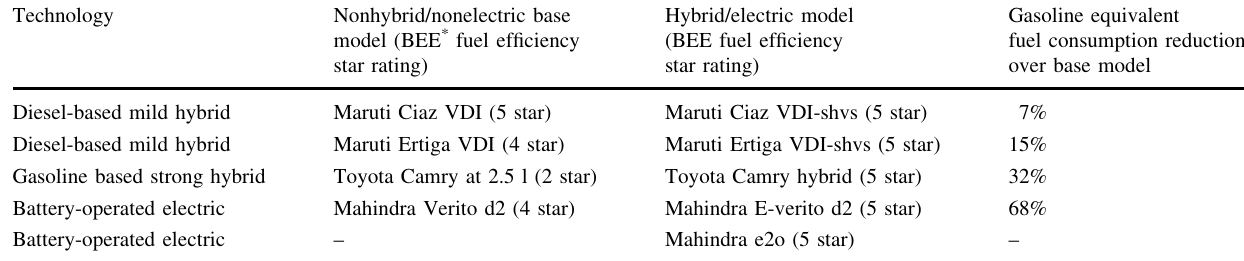
Table 1 Saving in fuel consumption in some top models